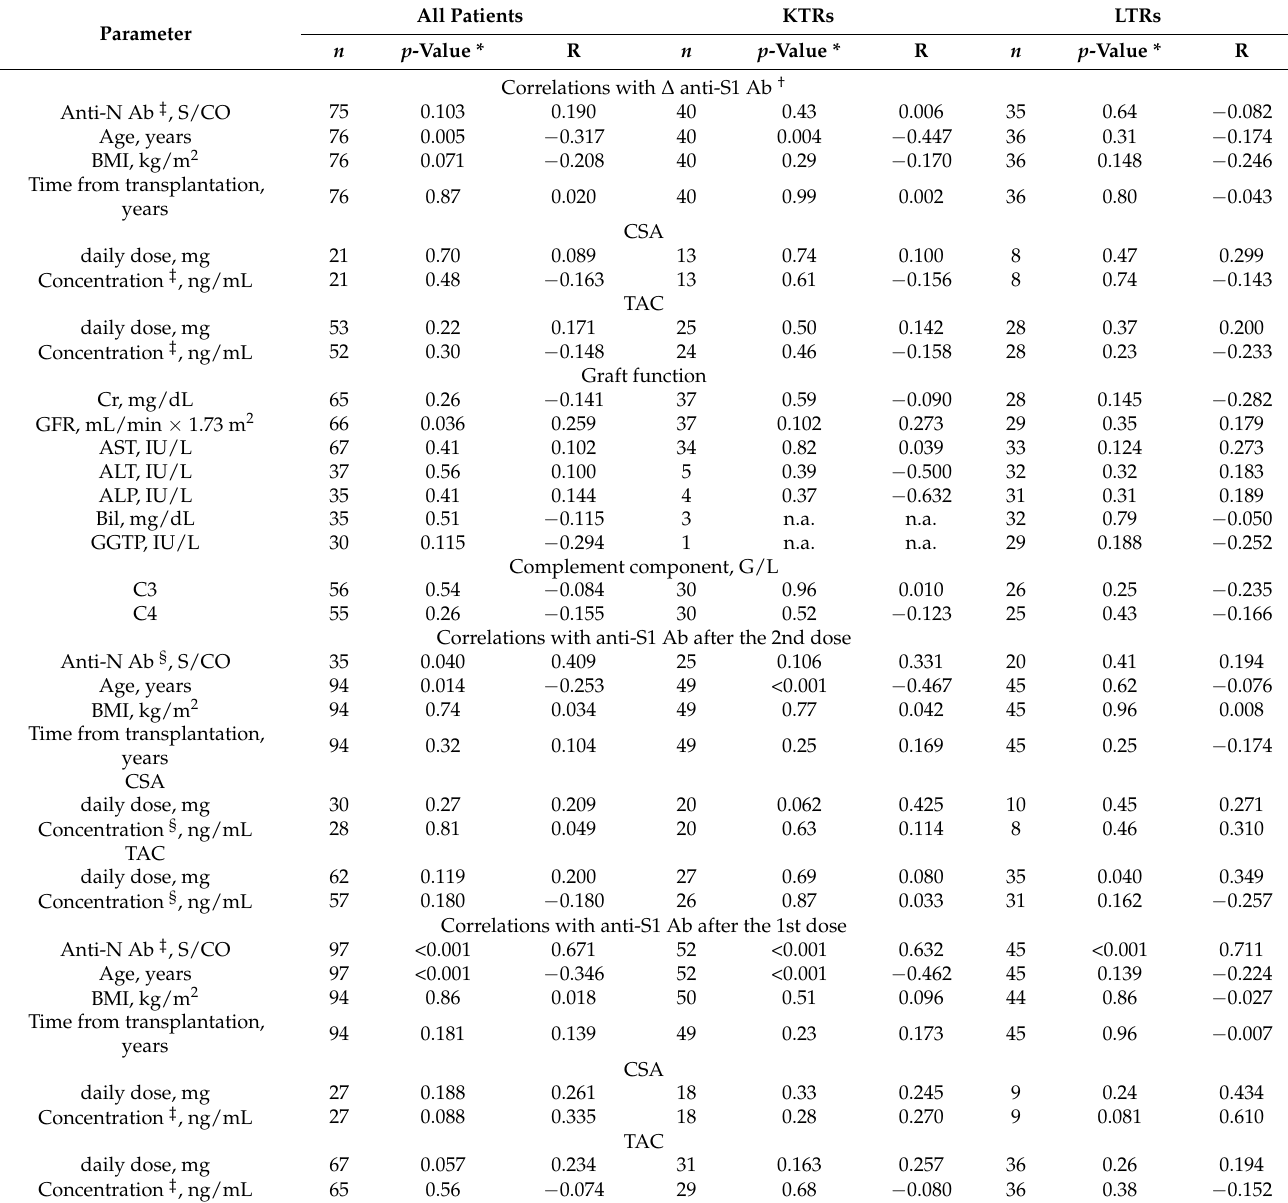
Table 3. Correlations of SARS-CoV-2 spike protein Ab concentration (AU/mL) after BNT162b2 vaccination with clini- cal